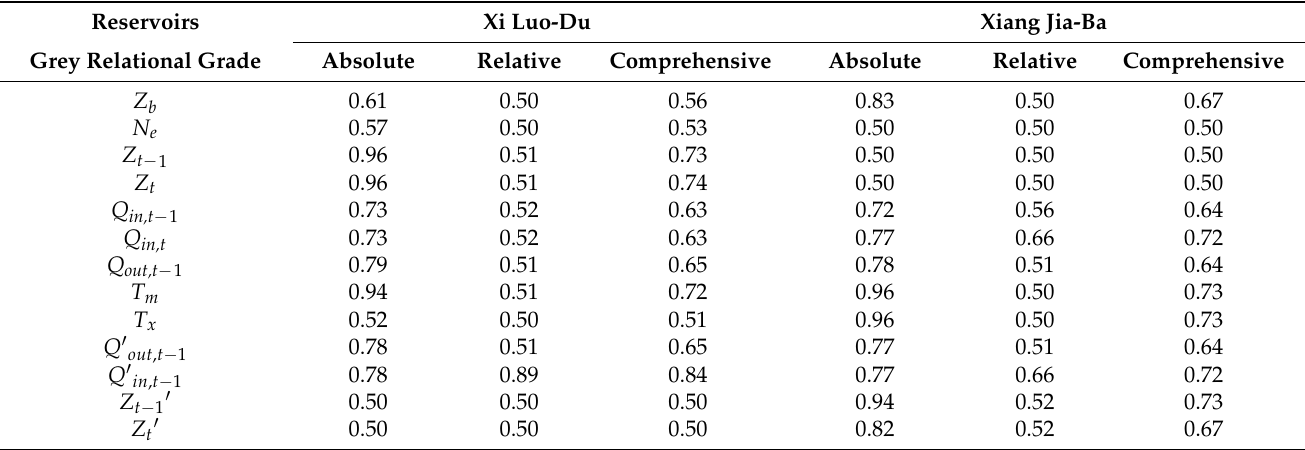
Table 2. The relational grade determined by